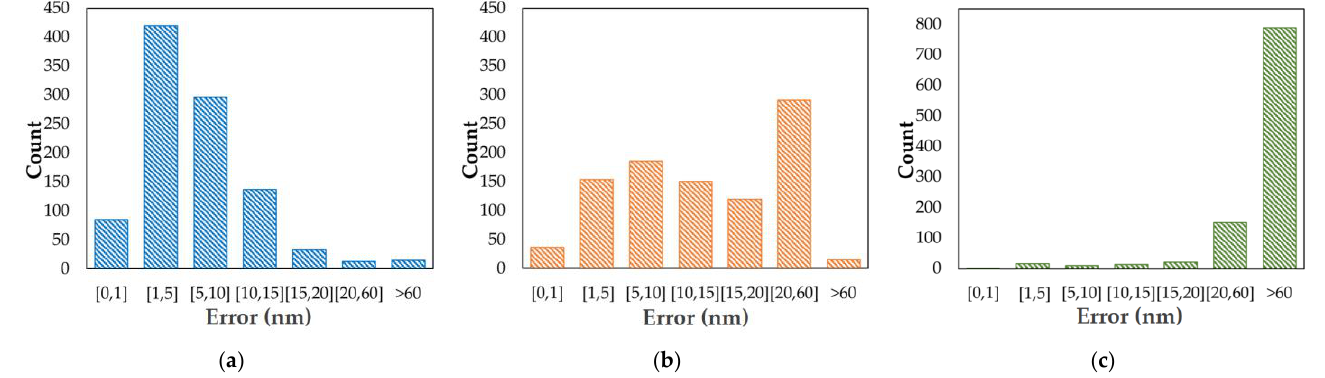
Figure 5. The error distributions of 1000 test feature vectors, using sub-aperture 0 as an example: ( a ) the results of ResNet-34; ( b ) the results of Alex Net; ( c ) the results of VGG-16.